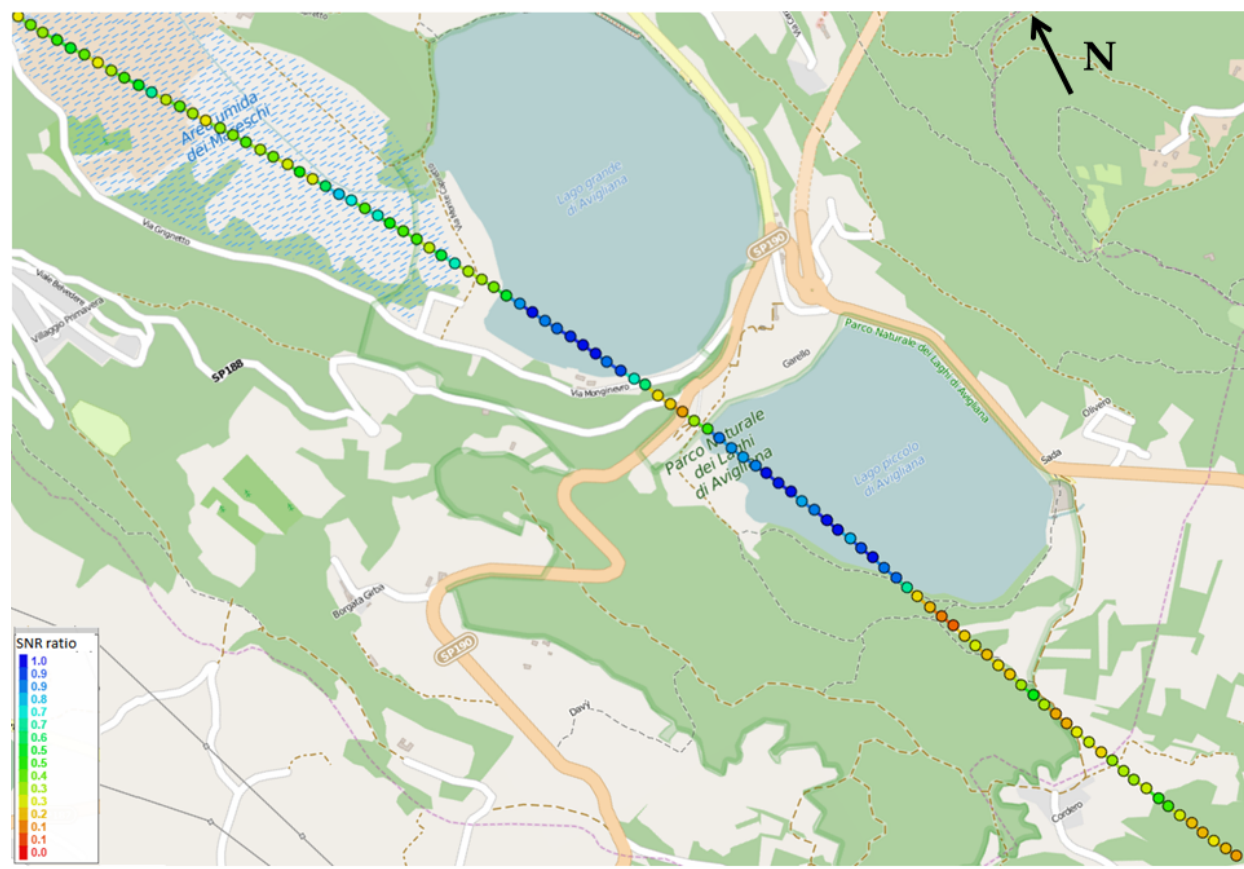
Figure 11. Specular points of PRN 13 over the Avigliana lakes. The color is proportional to the SNR ratio between the LHCP reflection and the direct GPS